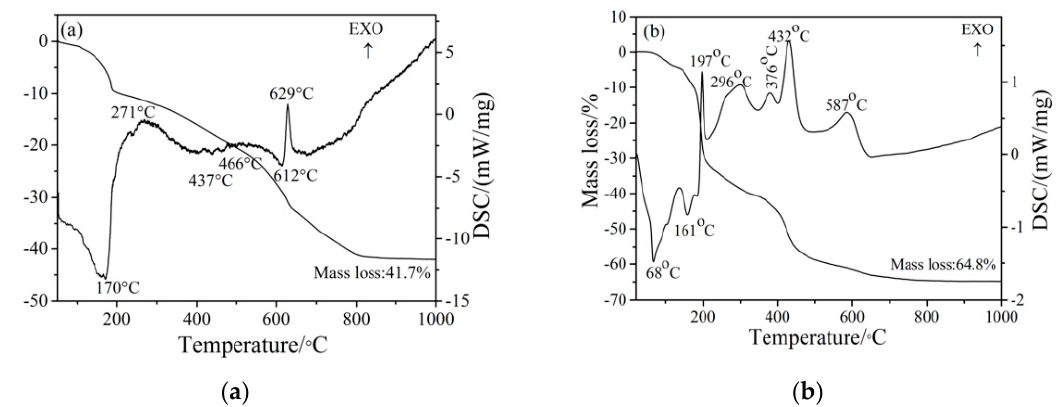
Figure 1. Plot of the differential thermal analysis and thermogravimetry data obtained at a heating rate of 10 ℃ /min from the precursors synthesized by different methods: ( a ) urea precipitation; and ( b ) sol–gel.